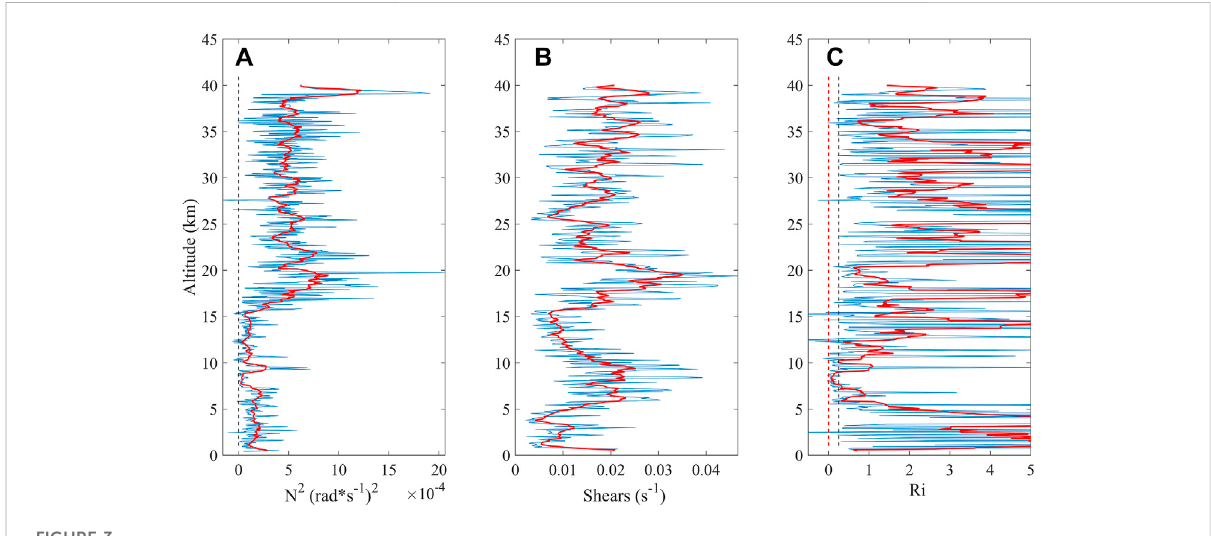
FIGURE 3 Vertical pro fi les of (A) N 2 , (B) wind shear, and the (C) Richardson number on 15 October 2021; the red lines denote the moving averages of the raw